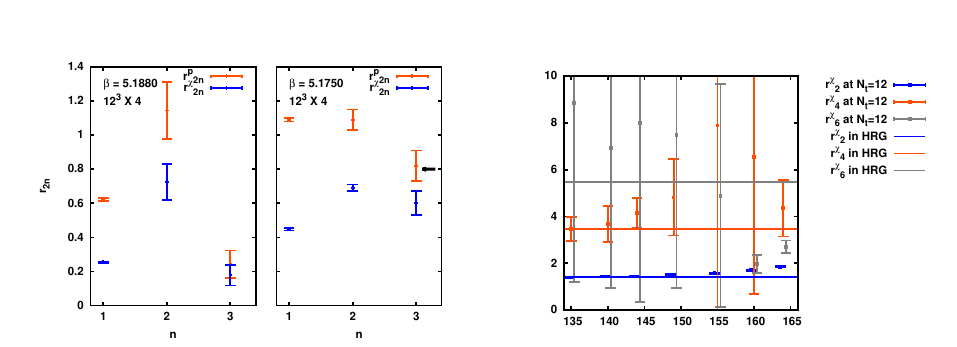
Figure 3: On the left panel: The ratios r p and r χ (eqn. 10) on an N t = 4 lattice. On the very left the 2 n 2 n temperature is close to the crossover temperature. Next to it the temperature is close to the temperature for the critical endpoint. The black arrow marks the value for the critical endpoint from [21]. On the right panel: The r χ (eqn. 10) ratios for di ff erent temperatures [29]. 2 n